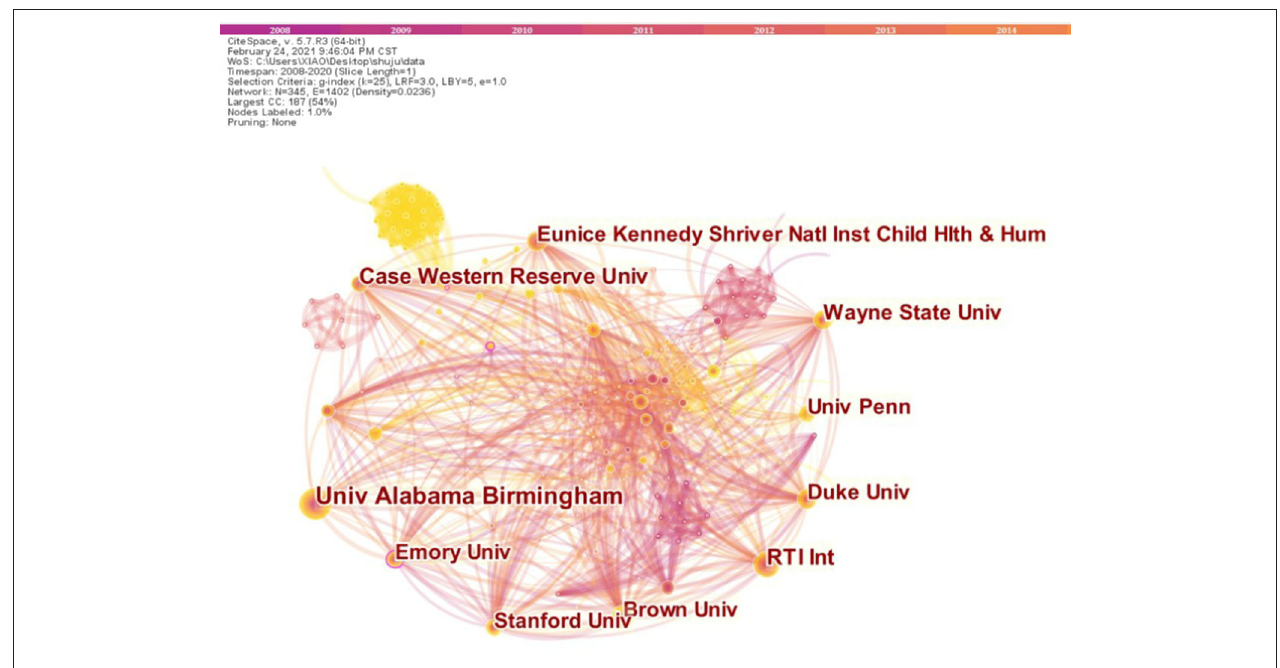
FIGURE 3 | Top 10 collaboration network of institution on BPD in extremely pre-mature infants.